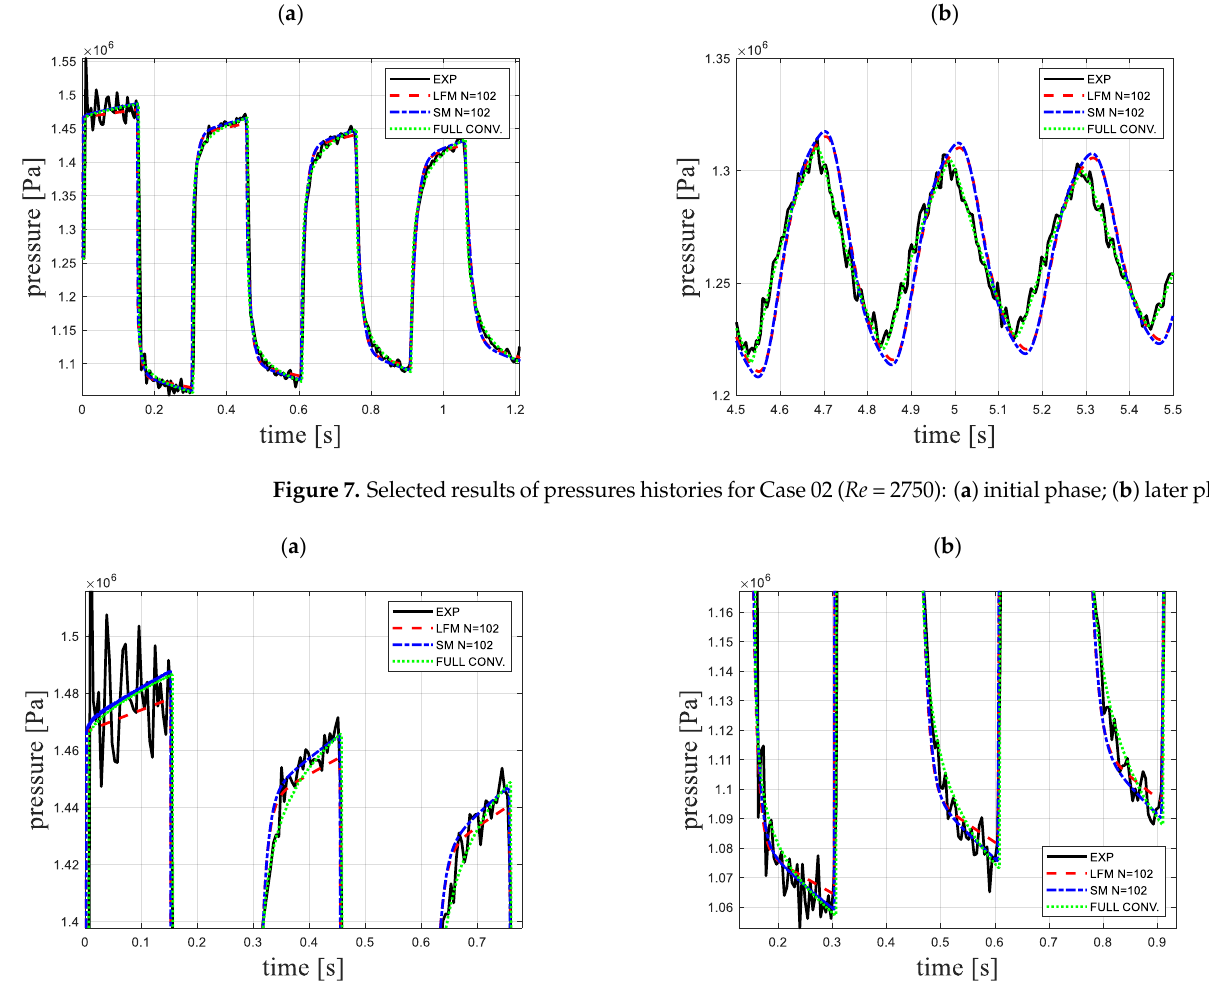
Figure 8. Enlargement of pressure histories of the first three amplitudes for Case 02 ( Re = 2750): ( a ) crest, ( b ) valley.